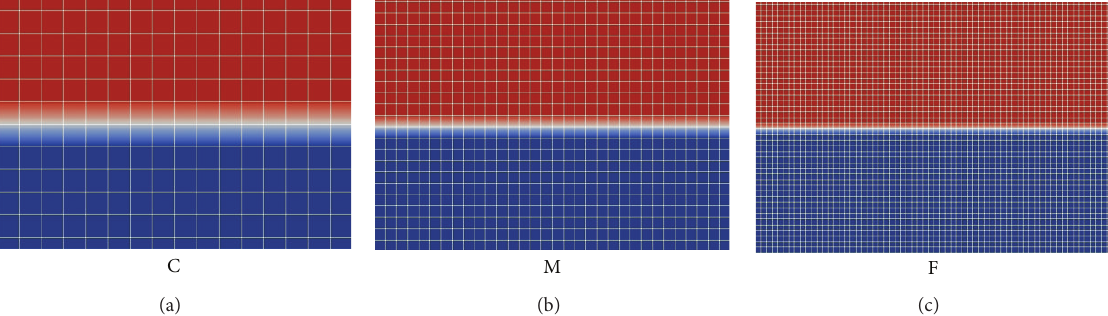
Figure 6: Relative mesh spacings for the 0.4 mm (C), 0.2mm (M), and 0.1 mm (F) meshes of the 2D annular geometry. Only a short vertical section showing the initial liquid-liquid interface is shown.